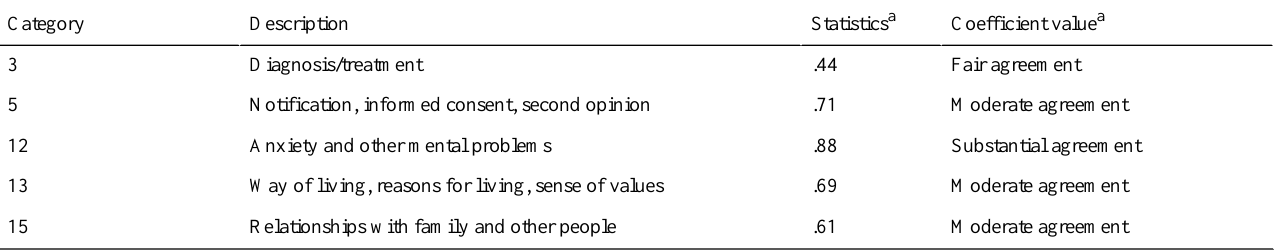
Table 4. Kappa coefficient values of five primary categories in the Shizuoka Classification